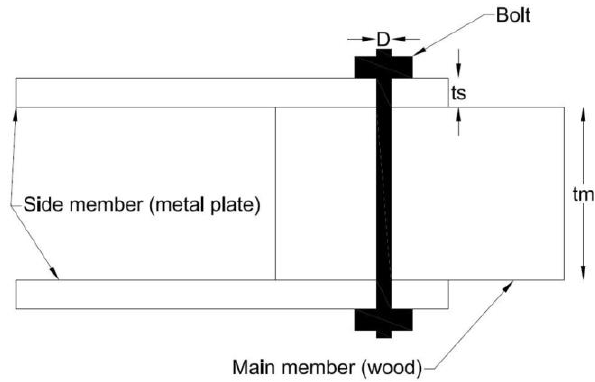
Figure 19. Wood-to-metal bolted connection in double shear.